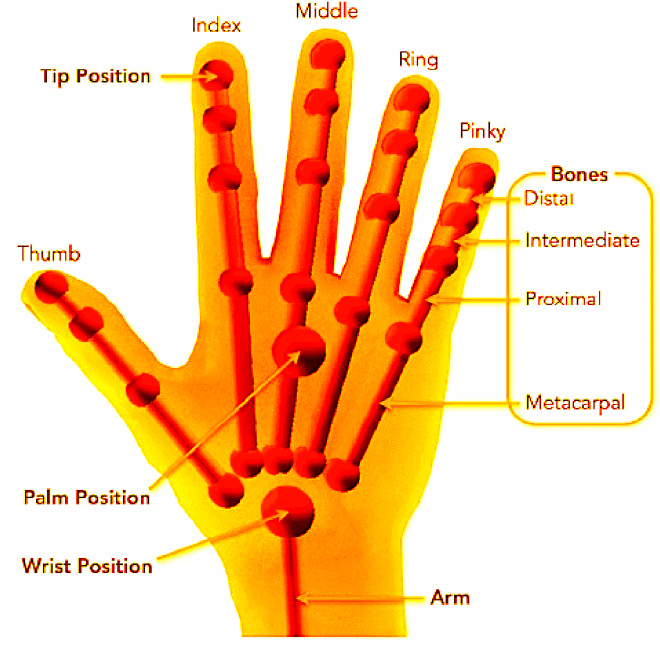
Figure 3. Positional data available from Leap Motion.